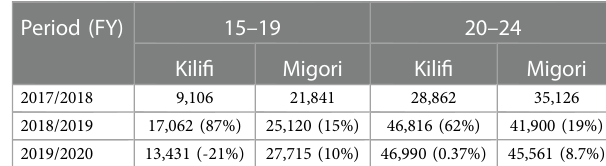
TABLE 2 Adolescent 15 – 24 years visits to health facilities for contraceptive services (Total number of adolescent visits to health facilities, percentage increase of adolescent visiting for contraceptive services for the period